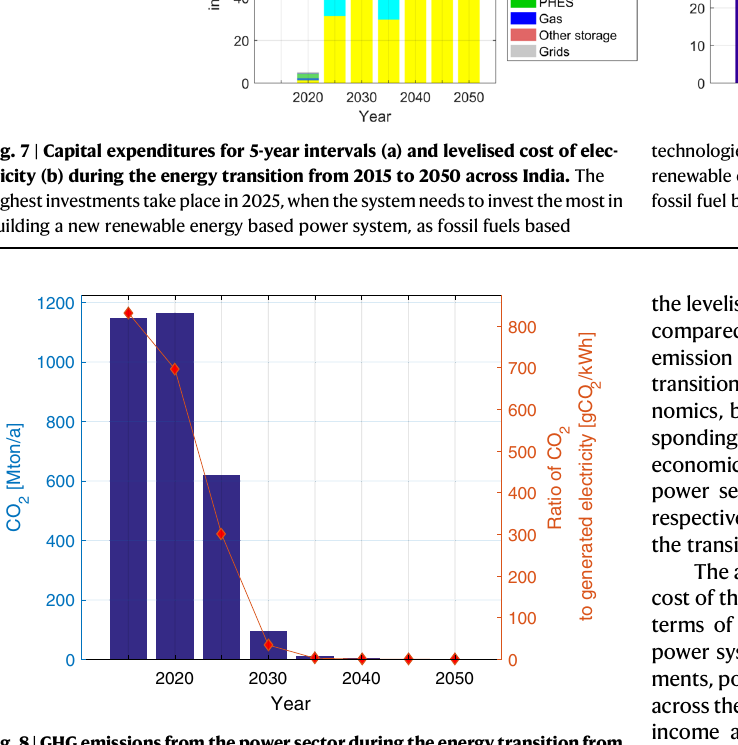
Fig.8|GHGemissionsfromthepowersectorduringtheenergytransitionfrom 2020to2050acrossIndia. Deepdefossilisationofthepowersectorispossibleby 2030 and a steady decline of emissions is possible beyond 2030 up to